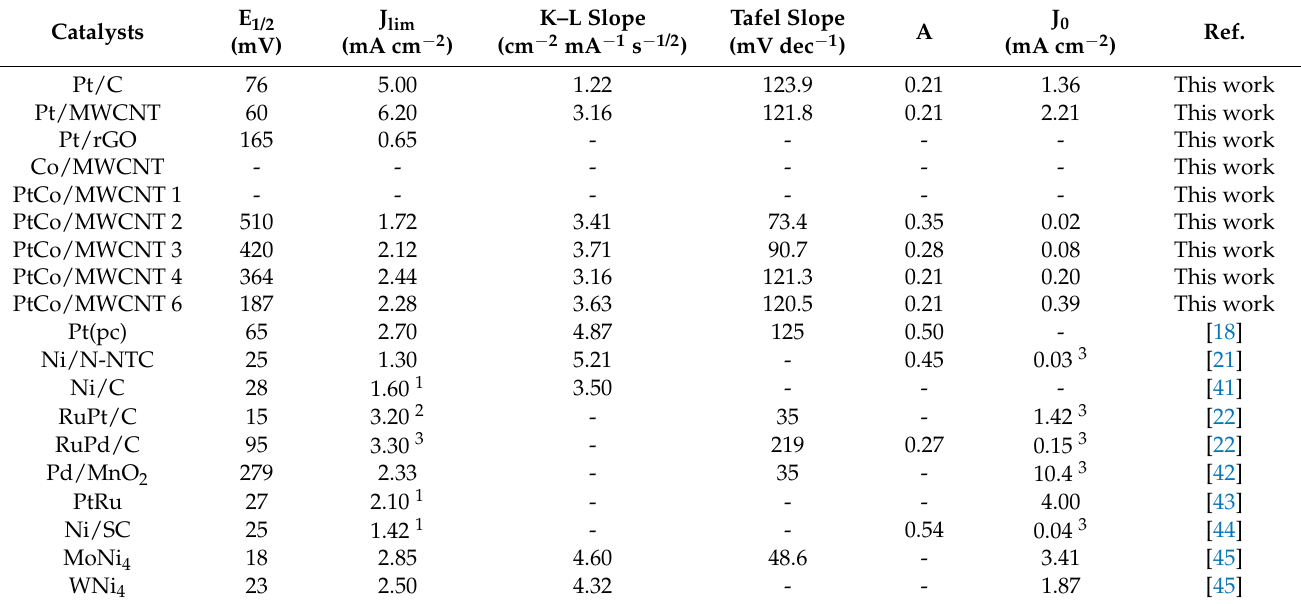
Table 4. Half-wave potential (E 1/2 ), limiting current density (J lim ), Koutecky–Levich slope, Tafel slope, electronic charge coefficient ( α ), and exchange current density (J 0 ) for the catalysts of this work.